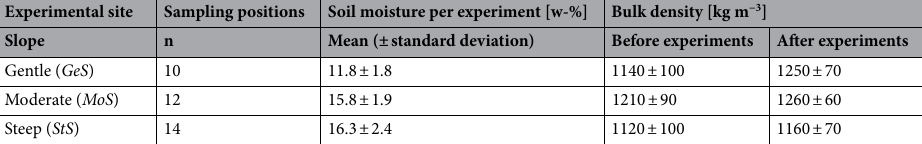
Table 1. Soil moisture measured before starting the tillage experiments and bulk density measured before and after the